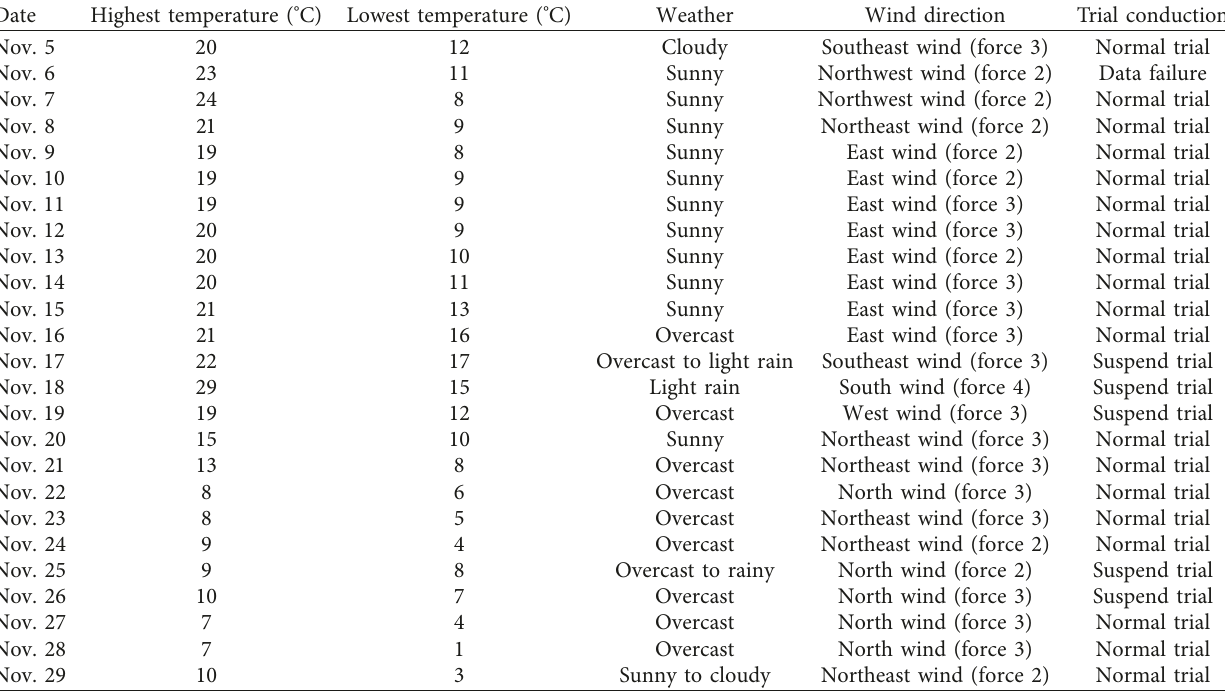
Table 1: Weather conditions at the trial site during the trial period.